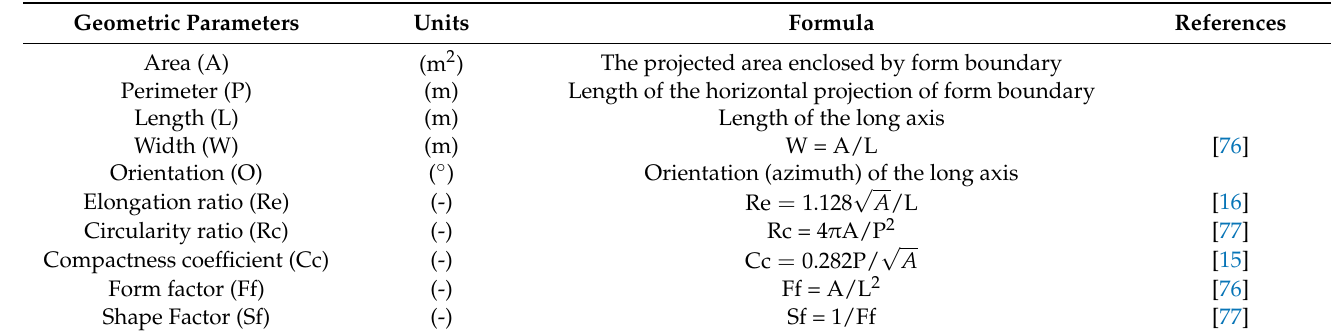
Table 3. Definitions of geometric